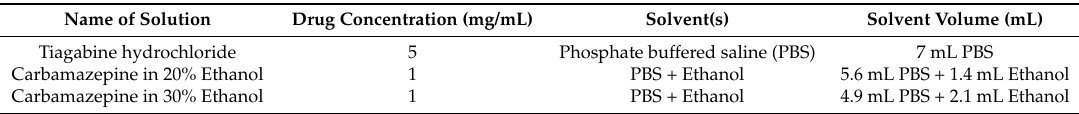
Table 1. Formulations of tiagabine and carbamazepine used in the